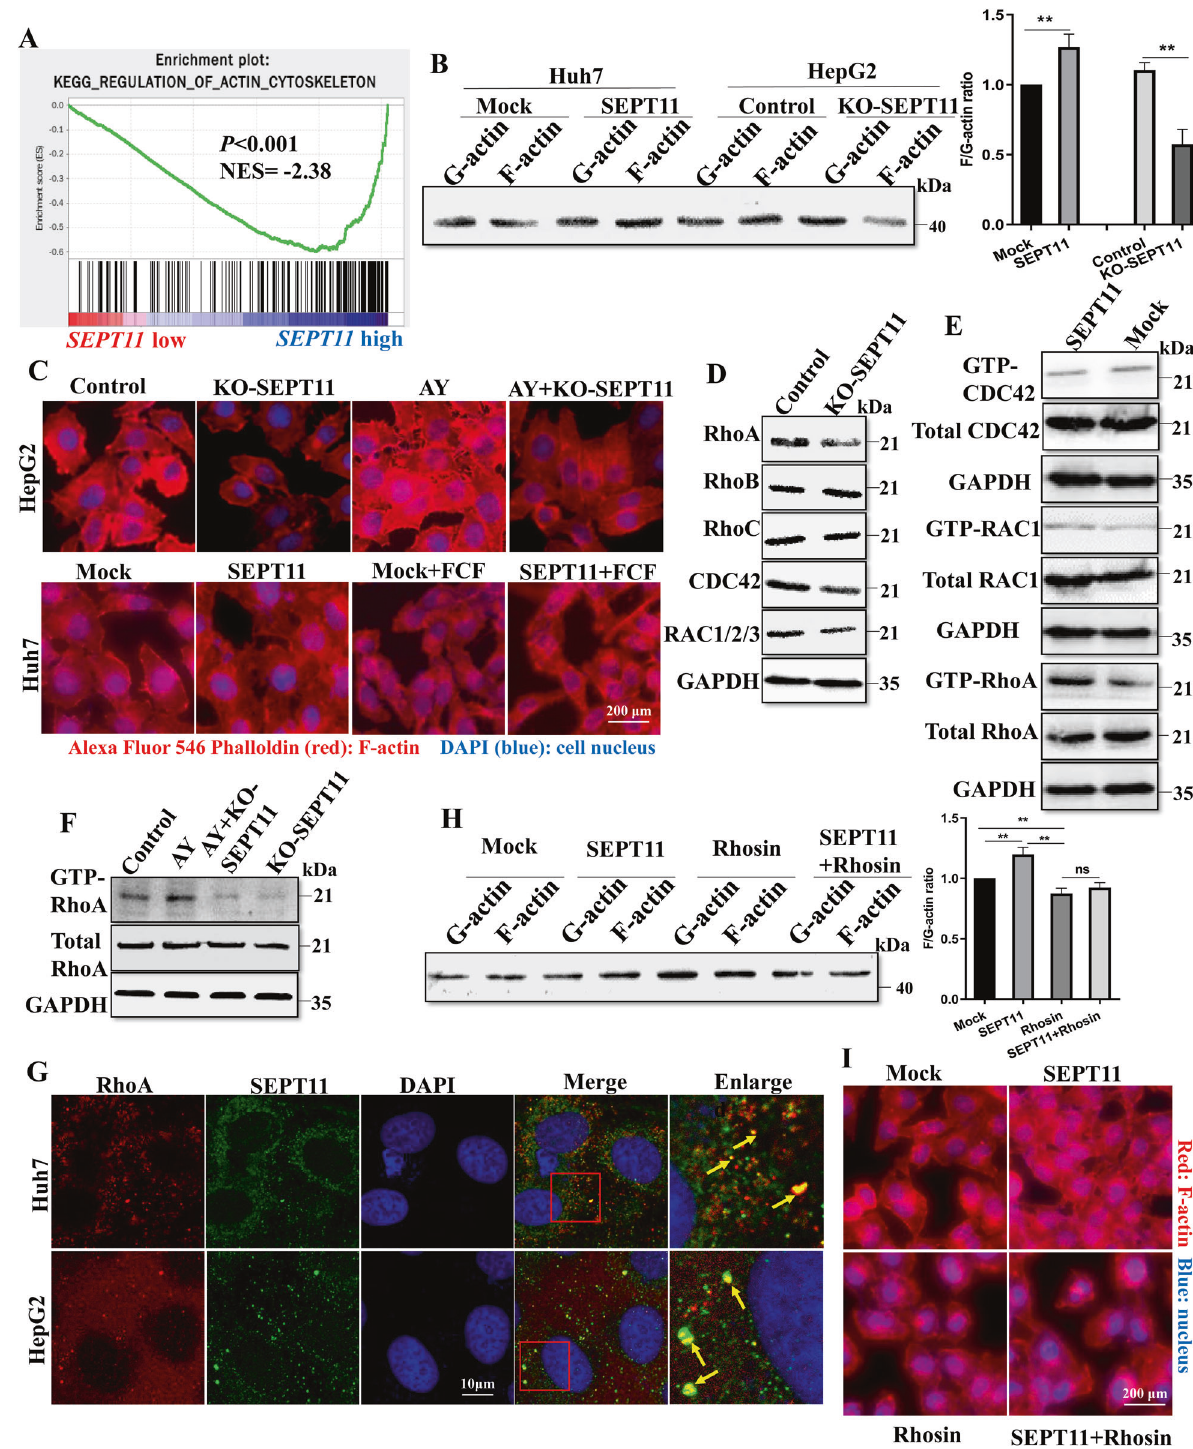
Fig. 4 SEPT11 promotes the activity of RhoA to regulate actin cytoskeleton reorganization. A GSEA analysis of high expression of SEPT11 in TCGA database affects the enrichment of genes in regulatory of actin cytoskeleton pathway; B WB experiment detects the effect of SEPT11 expression on actin dynamics in two types of cells; C Cell immuno fl uorescence was used to detect the effect of SEPT11 on actin content and arrangement; D The effect of KO-SEPT11 on the content of several major Rho proteins; E Rho pulldown activity assay kit was used to quantify the activities of RhoA, CDC42, and RAC1 in SEPT11 overexpressing cells; F The effect of AY expression on the activity of RhoA; G The co- localization of RhoA and SEPT11 in cells was observed by immuno fl uorescence combined with confocal, the arrows indicate puncta of SEPT11 co-localization with RhoA; H WB experiment detects the effect of RhoA inhibitor Rhosin on actin dynamics; I The effect of RhoA inhibitor Rhosin on the content and arrangement of actin was detected by cellular immuno fl uorescence.